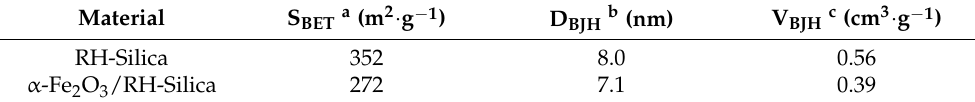
Figure 1. ( A ) N 2 physisorption isotherms obtained from a) RH-Silica and b) α -Fe 2 O 3 /RH-Silica materials. ( B ) XRD patterns of (a) RH-Silica and (b) α -Fe 2 O 3 /RH-Silica; XRD peak lines from standard powder diffraction files of hematite α -Fe 2 O 3 (PDF#33-0664) are shown as red lines with the corresponding crystal planes. Table 1. Textural properties of RH-Silica and α -Fe 2 O 3 /RH-Silica materials.